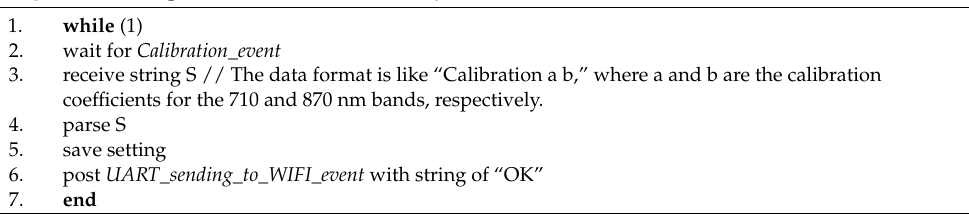
Algorithm 5: The pseudo code of the Calibration process